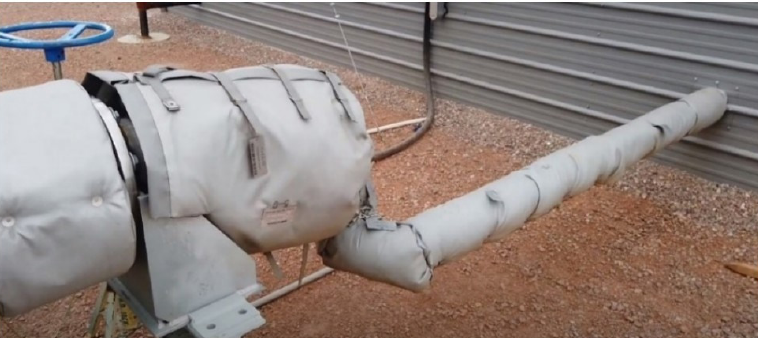
Figure 8. Pipe containing the CO 2 that will be injected into the carbonation chamber. Source: [[38]].